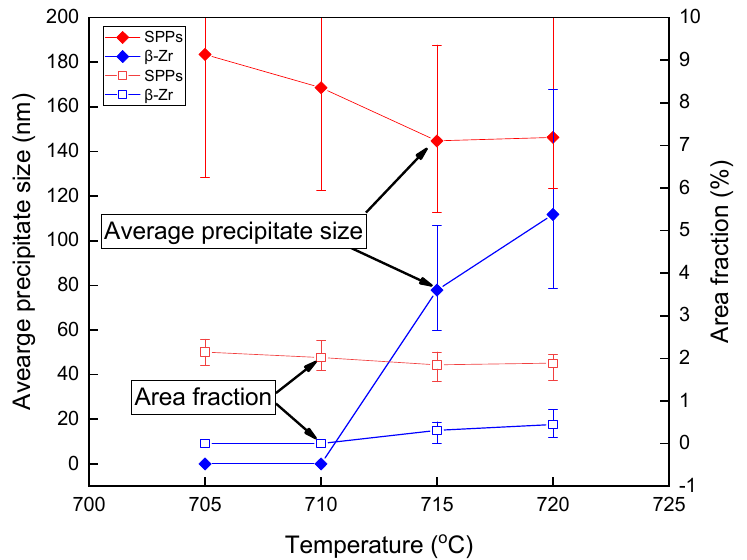
Figure 7. Statistical results of β -Zr and SPPs represented by area fraction evolution and precipitates size. It is noteworthy that Nikulina et al. [23] found the phase transition temperature is about 650 ◦ C in Zr-1% Sn-1% Nb-0.4%Fe alloy, and a temperature of 680 ◦ C is